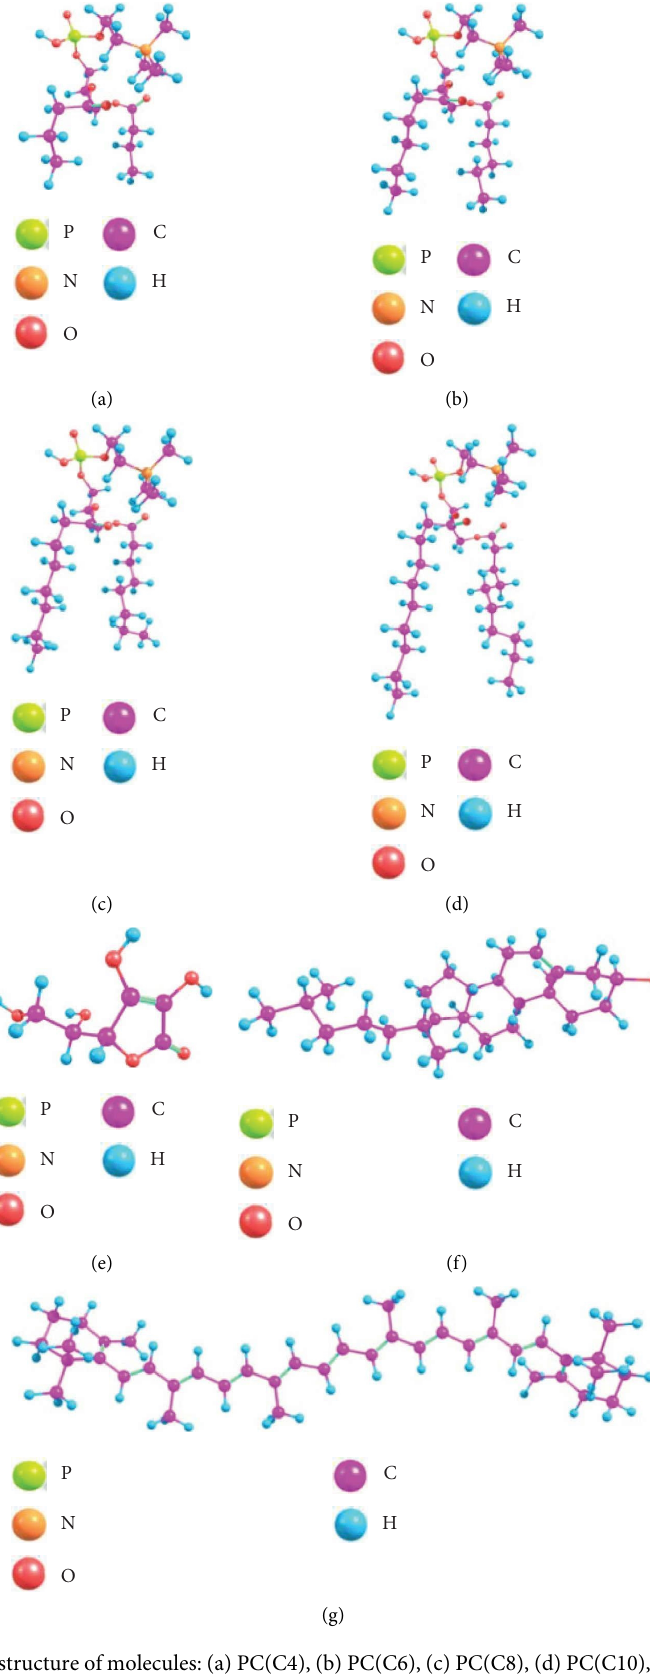
Figure 1: Optimized geometric structure of molecules: (a) PC(C4), (b) PC(C6), (c) PC(C8), (d) PC(C10), (e) vitamin C, (f) cholesterol, and (g)